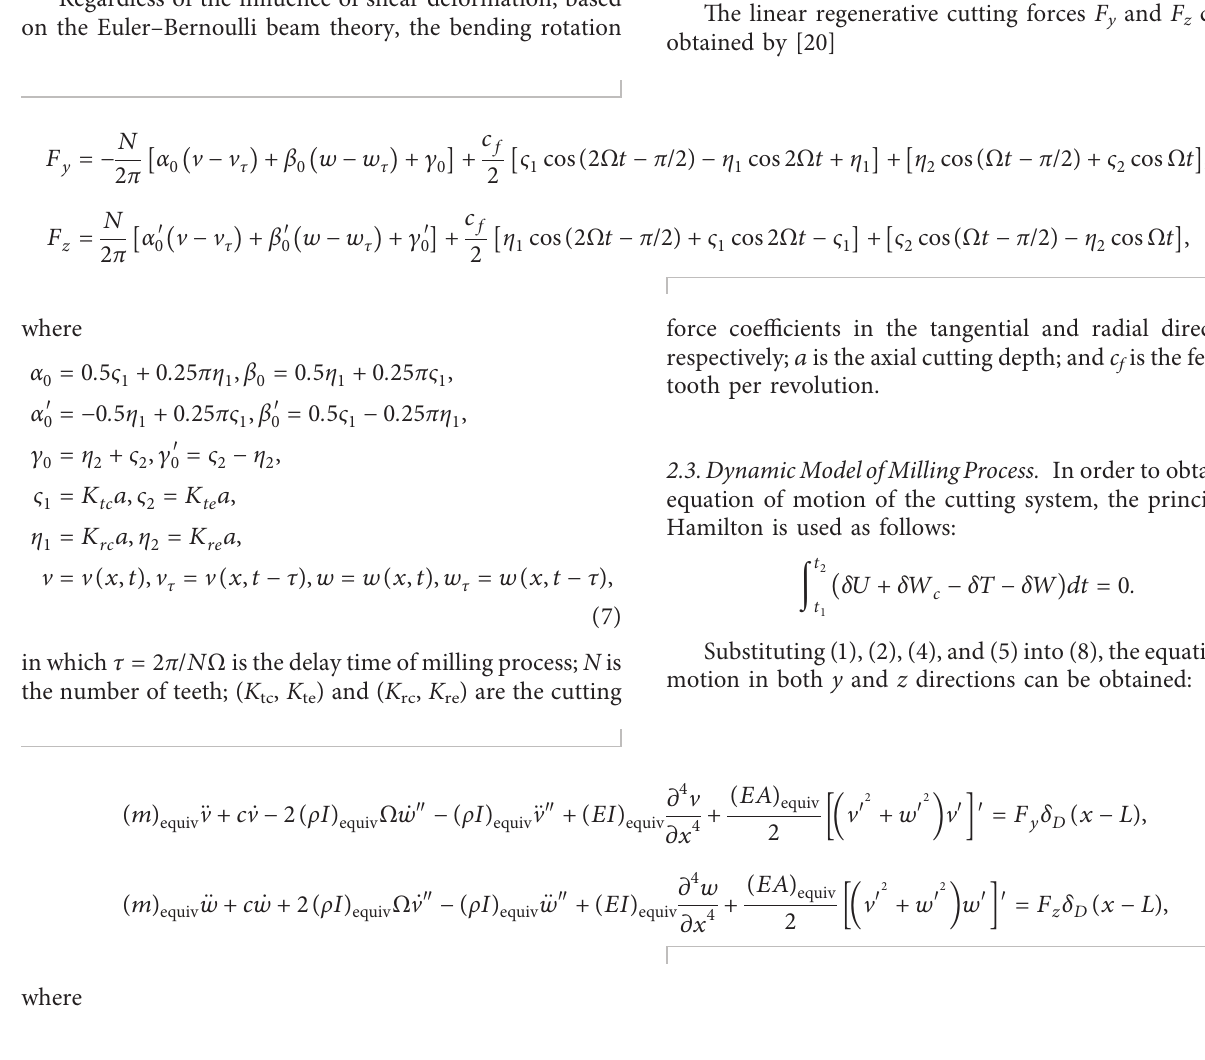
Figure 1: Composite cutting tool with nonplanar where Q refers to the off-axis stiffness coefficient of the k th 11 layer for the composite cutting tool.